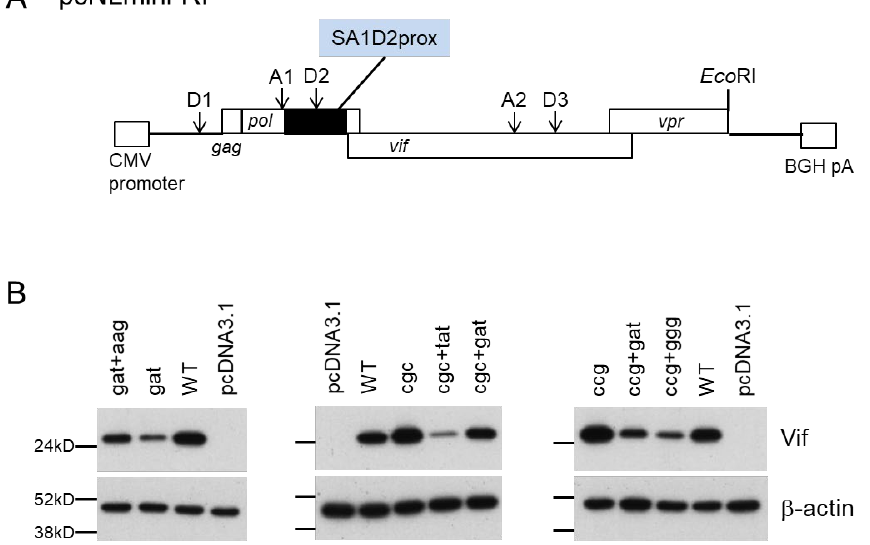
Figure 7. Vif expression levels of a newly constructed minigenome (pcNLmini-RI) vector. ( A ) Or- ganization of the minigenome. The pcNLmini-RI vector was constructed as described in the Mate- rials and Methods. Splicing (D1, A1, D2, A2, D3) and Eco RI sites in the minigenome vector corre- sponding to those in the authentic HIV-1 NL4-3 clone are shown. A black box indicates the SA1D2prox region. CMV promoter, cytomegalovirus enhancer-promoter; BGH pA, bovine growth hormone polyadenylation sequence. ( B ) Vif expression levels of the minigenome vectors carrying day 1 post-transfection, cell lysates were prepared for Western blotting analysis using anti-Vif and